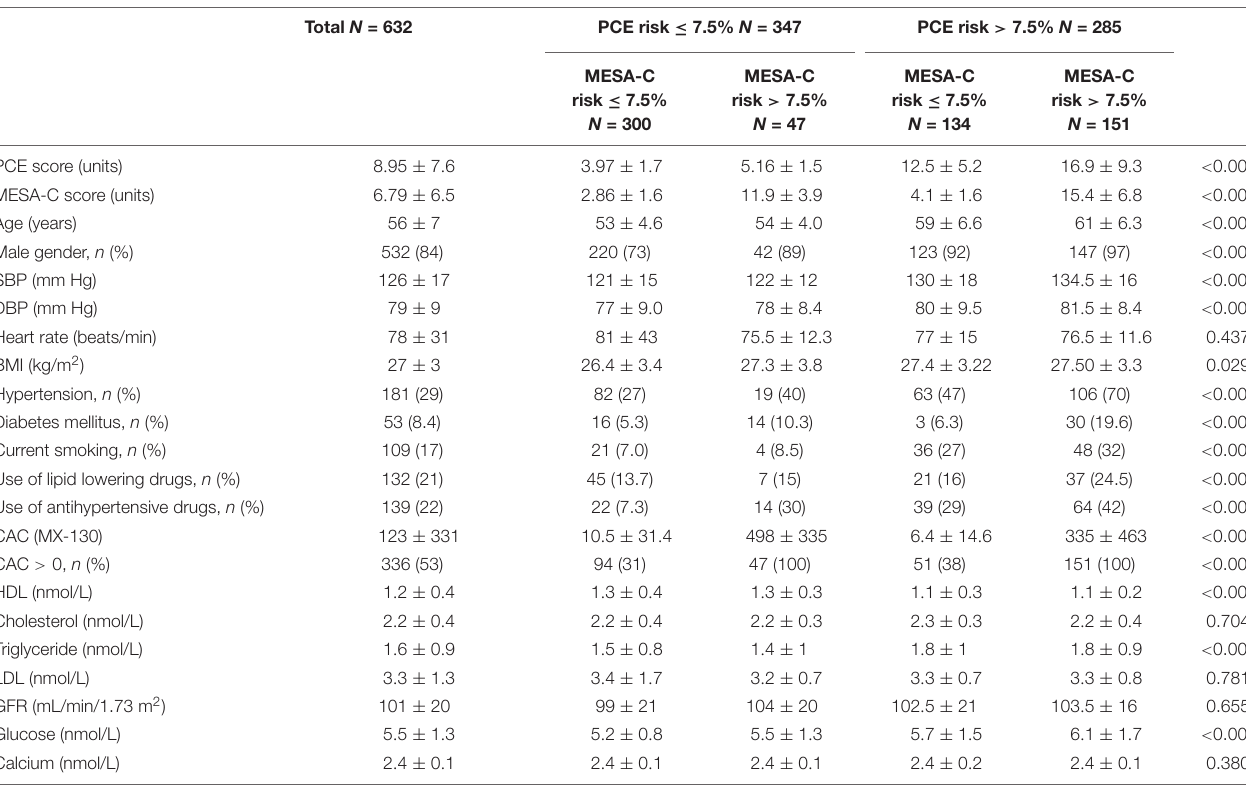
TABLE 1 | Baseline characteristics by PCE and MESA risk